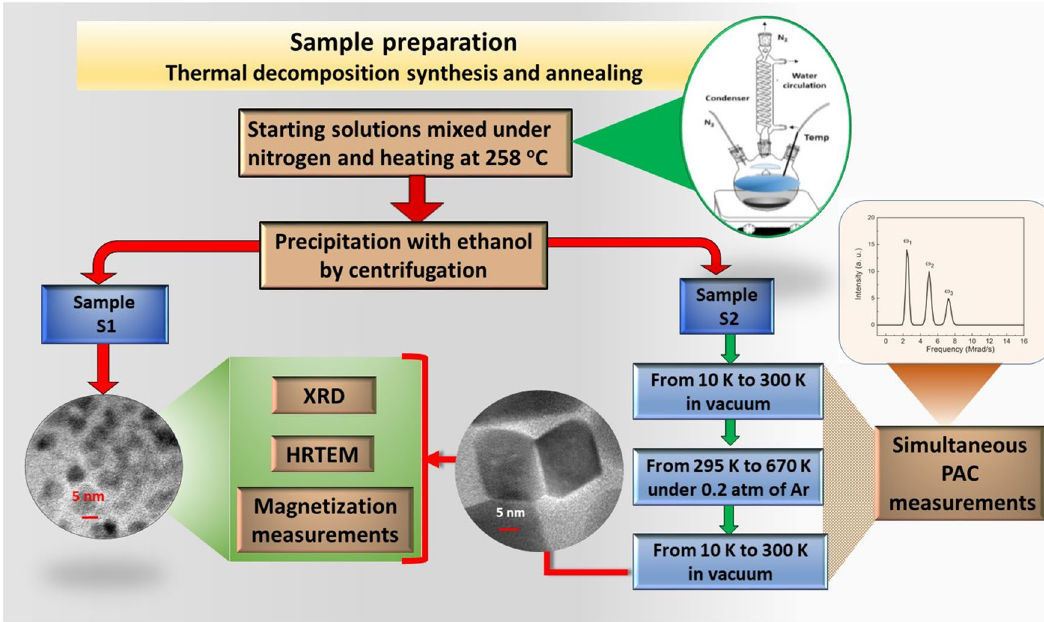
Figure 7. Scheme displaying the steps of the samples preparation and characterization by XRD, TEM and magnetization measurements of S1 and S2 as well as the measurements by PAC before (at temperatures below RT) and during the steps of the annealing of S2. PAC measurements in the 10–300 K range after synthesis are representative of sample S1 (see